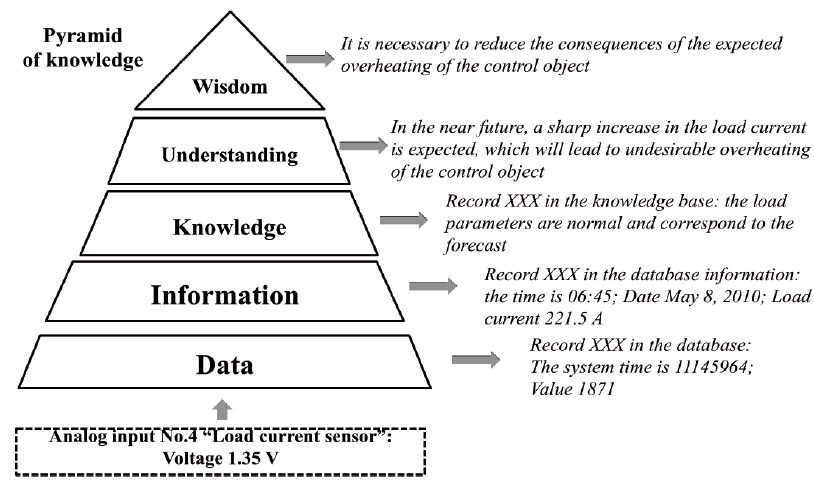
Fig. 2. Elements of a cognitive cooling control systembased on pyramid of